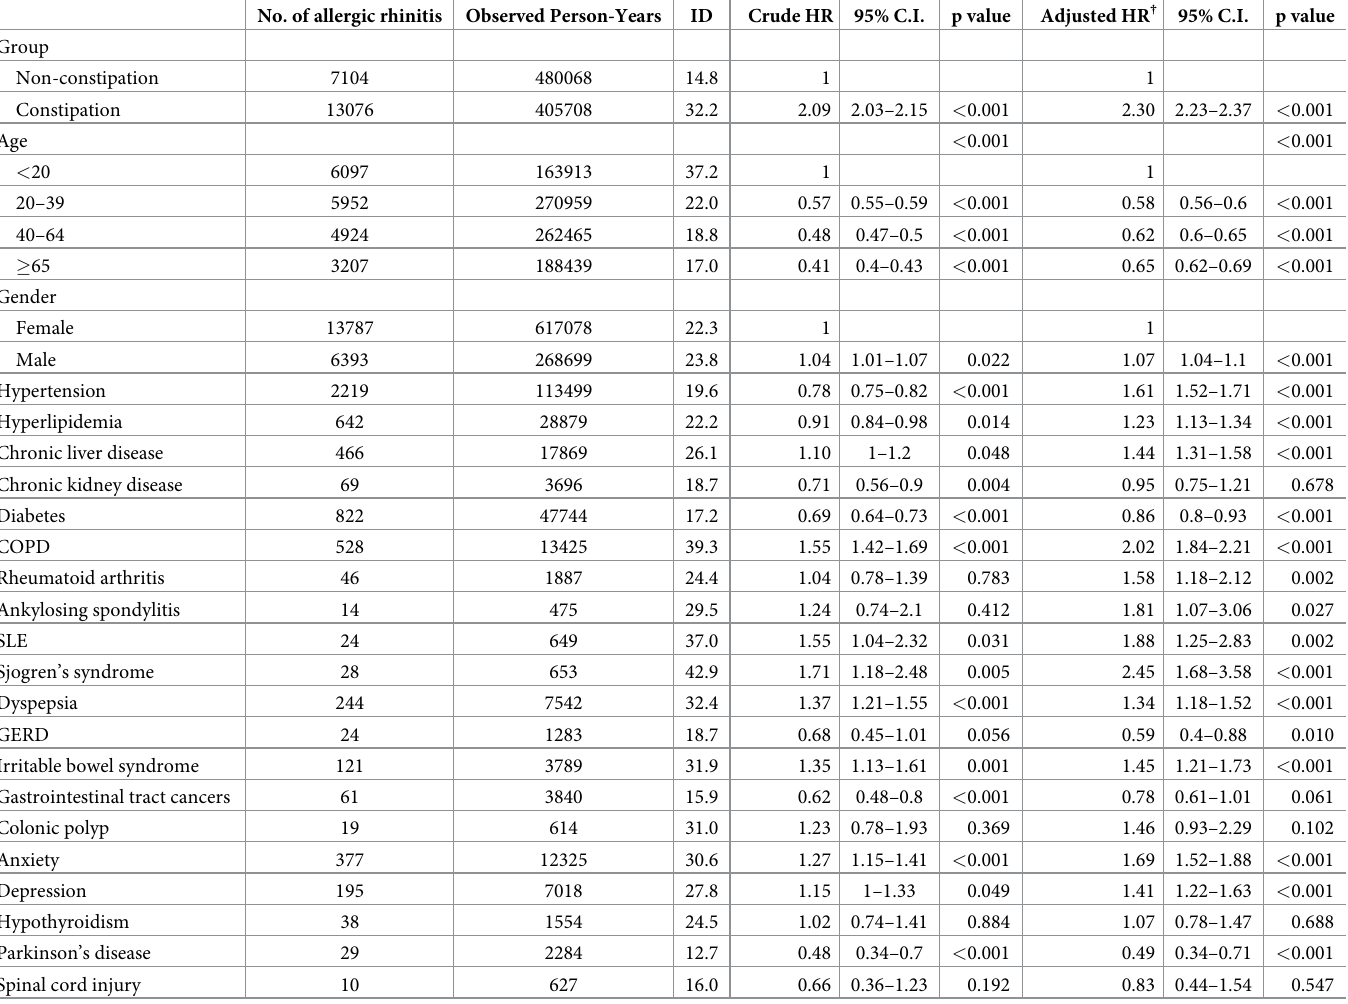
Table 2. Multiple Cox proportional hazard regression for the estimation of adjusted hazard ratios for